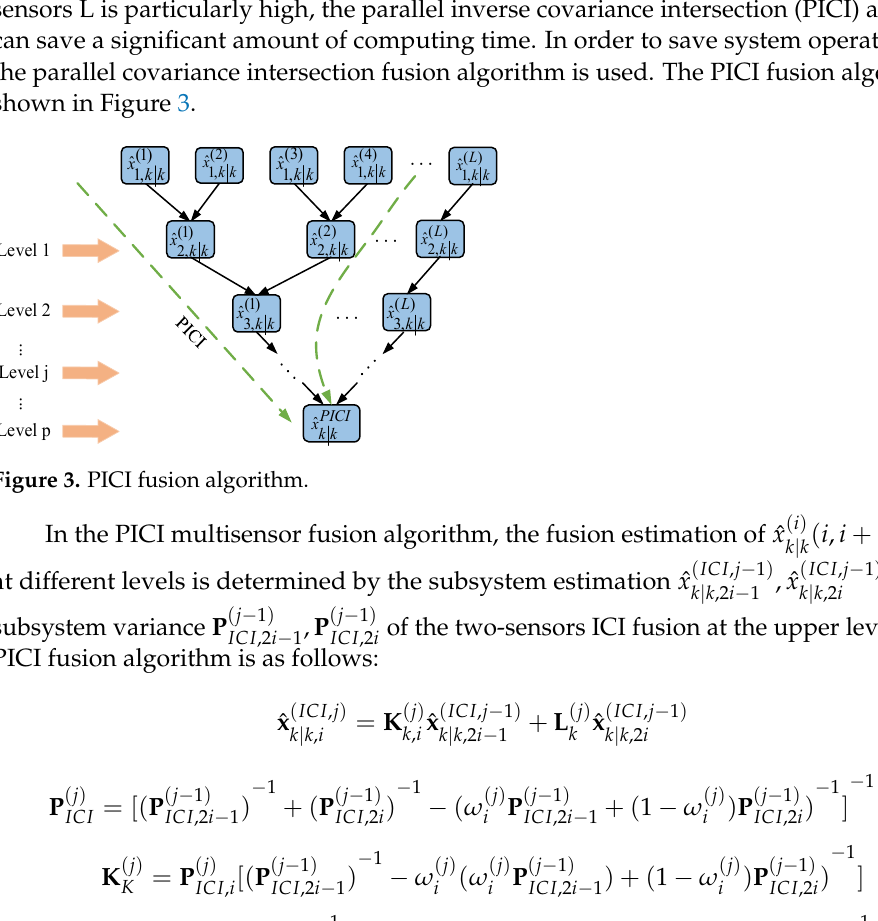
Figure 2. SICI fusion algorithm.